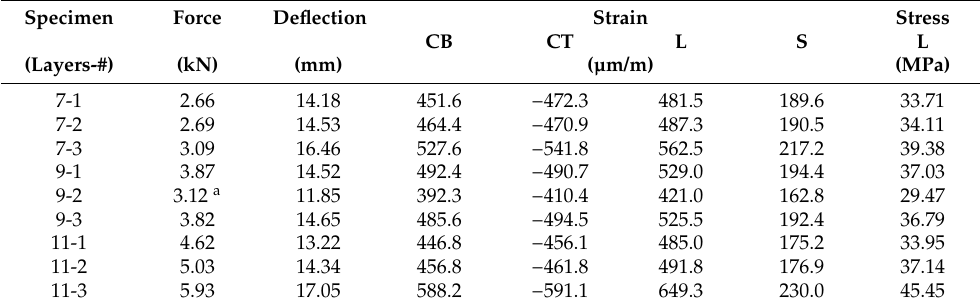
Table 2. Results of the quasi-static bending experiments, undamaged specimens. Values for first glass ply cracking, which is equal to peak force points except for Specimen